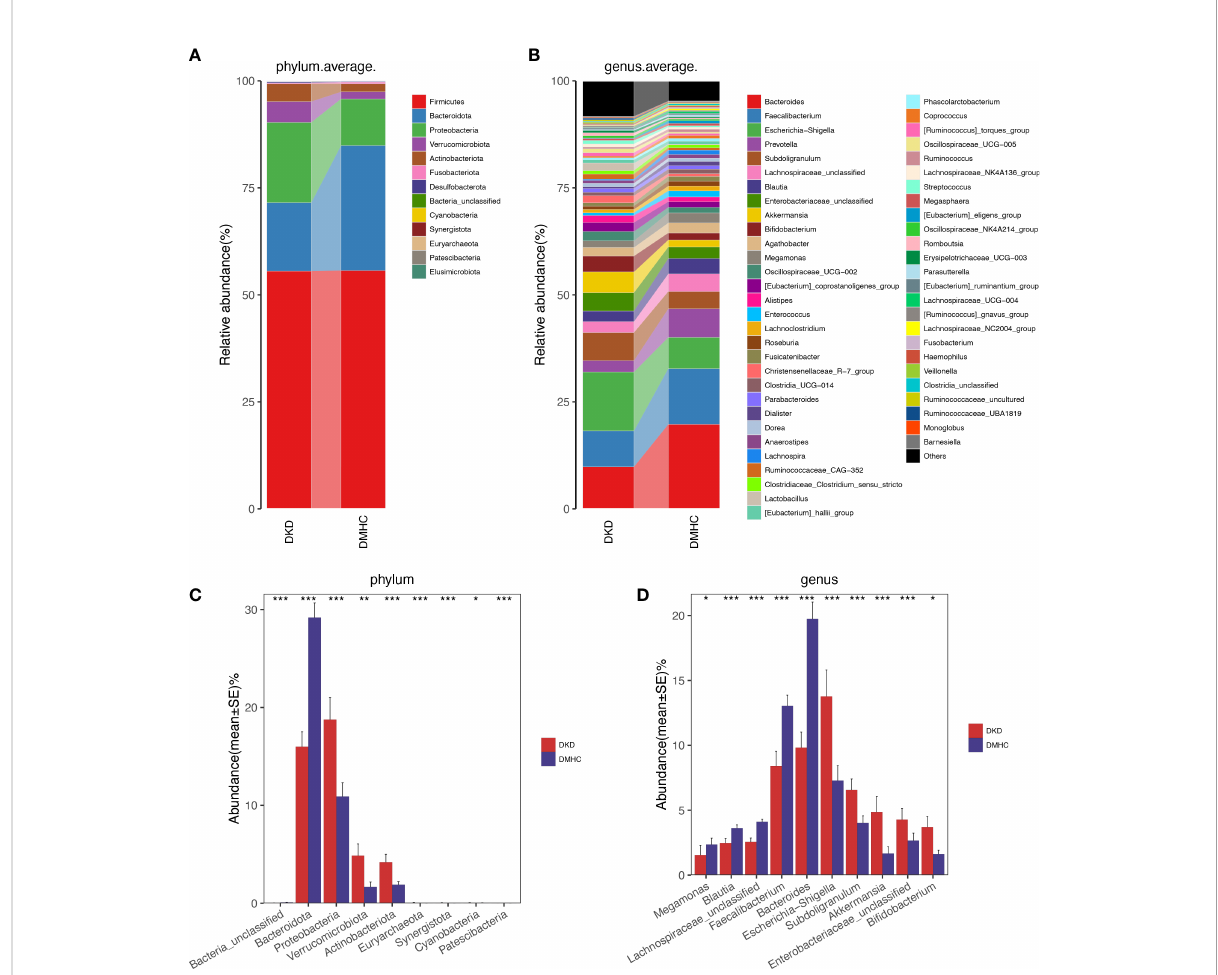
FIGURE 3 Microbial communities altered between DKD patients and non-DKD populations. In discovery phase, composition of gut microbiome at the phylum (A) and genus (B) level. Kruskal – Wallis rank-sum test was used to compare and identify signi fi cantly different bacteria at the phylum (C) or genus (D) level. Only bacteria with gradually increased or decreased abundance between two groups were shown. * p < 0.05, ** p < 0.01, *** p <